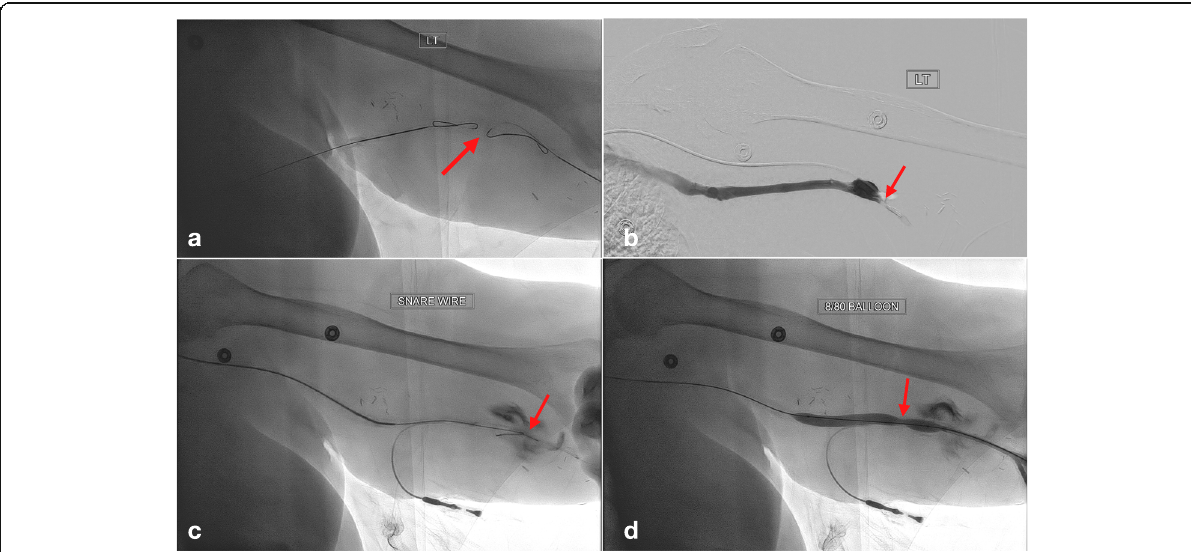
Fig. 2 Failure to advance a 018 ″ guidewire viz. local antegrade and retrograde accesses due to focal obstruction (arrow) in the midportion of the graft correlating with area of delamination seen on ultrasound ( a ). Transfemoral access used to selectively catheterize the left brachial vein and contrast injection confirmed position within the graft vein anastomosis (arrow) ( b ). Four to eightmillimeters microsnare via antegrade micropuncture sheath used to externalize the glidewire from the arm creating a through and through wire access (arrow) ( c ). Persistent flow defect is seen in the mid-portion of the graft (arrow) after Balloon angioplasty and platelet plug embolectomy of the graft-artery anastomosis demonstrating the area of delamination which needs to be grafted ( d )